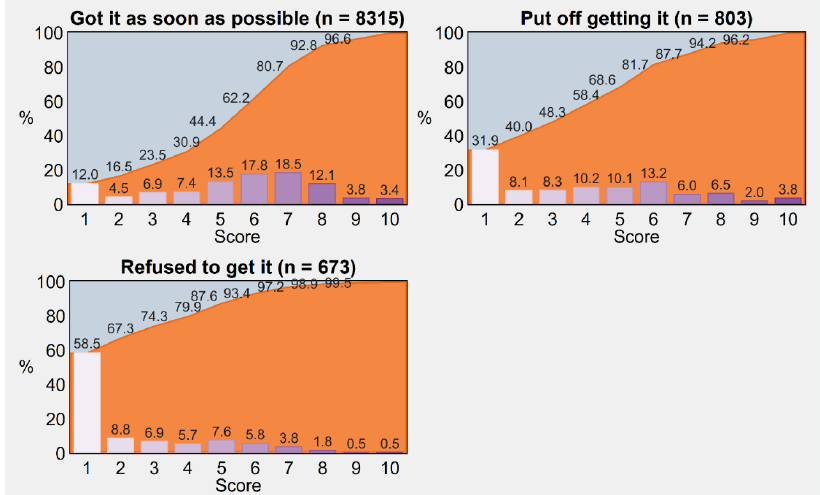
Figure 3. Trust in the Italian government scored on a scale from a minimum of 1 to a maximum of 10, by COVID-19 vaccine uptake status. Percentages were post-stratified by using the distribution of Italy’s resident adult population by NUTS region, gender, and age group as of January 1, 2022. Notes: Cumulative frequencies are displayed with the aid of area charts in the background. Trust among vaccine-exempt individuals is not displayed due to small numbers ( n = 209). Abbreviations: COVID-19, coronavirus disease 2019; NUTS, Nomenclature of Territorial Units for Statistics.